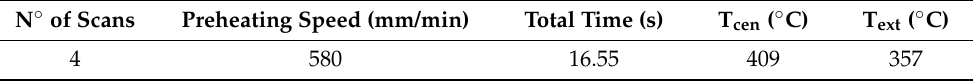
Table 10. Average maximum temperatures for the experiments of four scans.